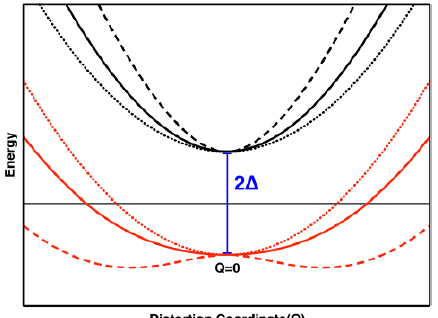
Figure 12. The excited state (black) and ground state (red) potential energy surfaces associated with varying values of F 2 (Dotted: F 2 = 0, solid: F 2 = Δ ·K 0 , dashed: F 2 = 2 Δ ·K 0 ) When the condition F 2 > Δ ·K 0 is met one observes that the single-well ground state potential energy surface distorts into a double- well potential. The F 2 > Δ ·K 0 criteria describe a strong PJT effect. (Adapted with permission from J. Am.